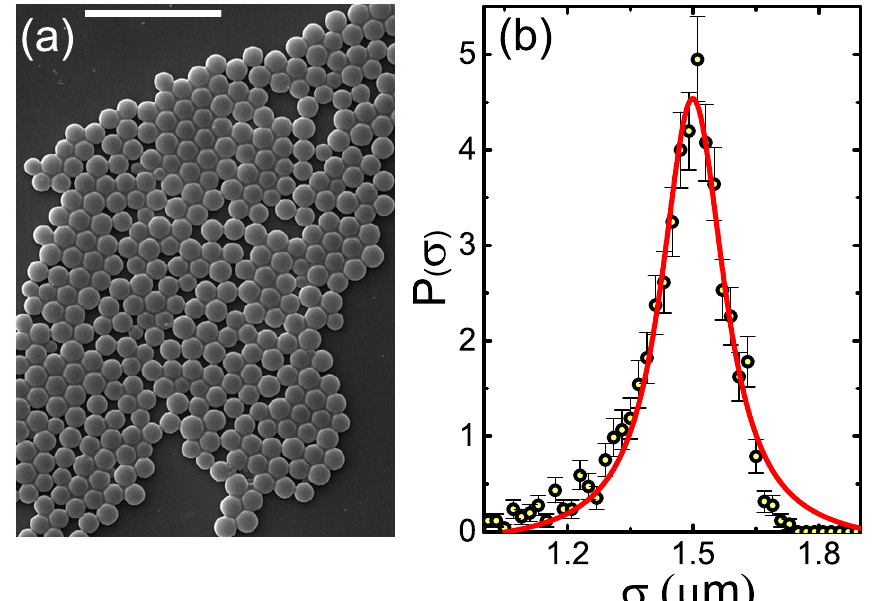
Figure 1. ( a ) SEM image of the original colloidal spheres demonstrates that their polydispersity is relatively low. The scale bar is 10 µ m; ( b ) The distribution of particle diameters P ( σ ) (symbols), as obtained by SEM measurements. The red curve is a Voigt function fit, shown as a guide to the